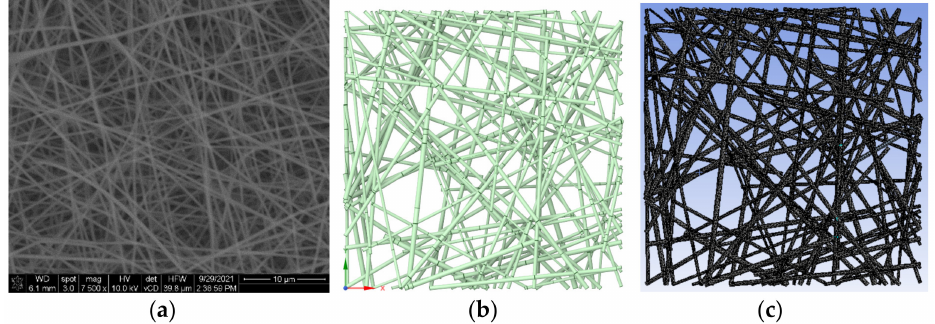
Figure 7. Non-intersecting air filter media geometry. ( a ) SEM image of electrospun filter media. ( b ) Top view as created with SpaceClaim. ( c ) Filter media meshed by Ansys